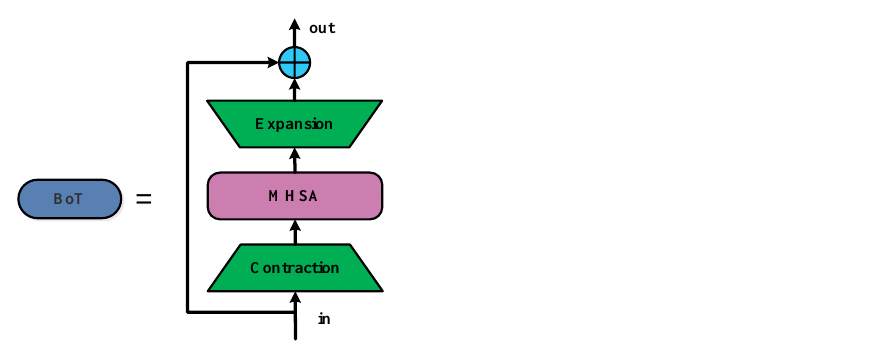
Figure 9. The BoT block in BoT3. The detailed structure of the MHSA is shown in Figure 10. ⊕ stands for the element-wise sum